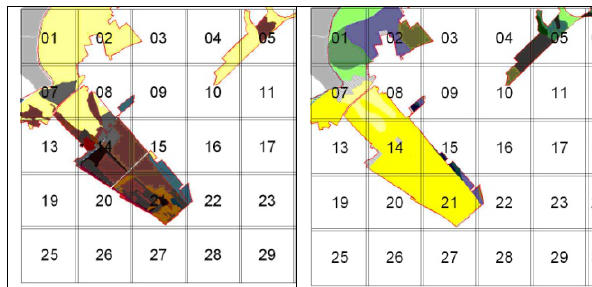
Figure 9. Results from the image classification algorithm: pink areas represent the oak tree areas (accuracy 90.03%); green areas represent areas being outside the oak tree forest (accuracy